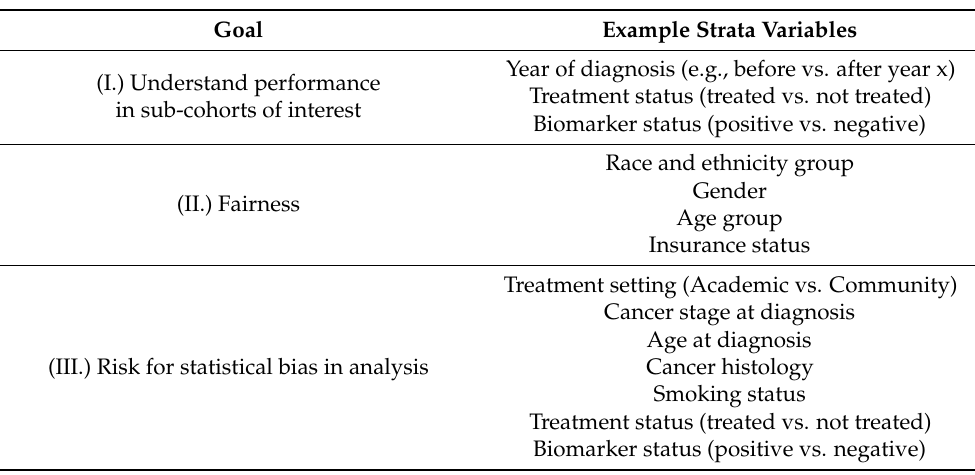
Table 2. Stratified analysis steps and example